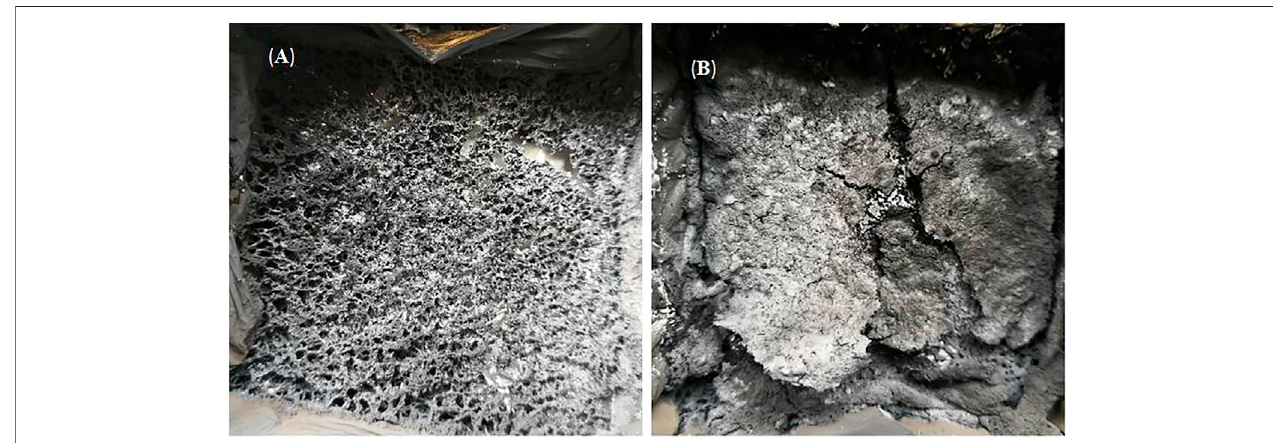
FIGURE 10 | PUF char layer after combustion (A: PUF, B: PUF/SA-g-DOPO).